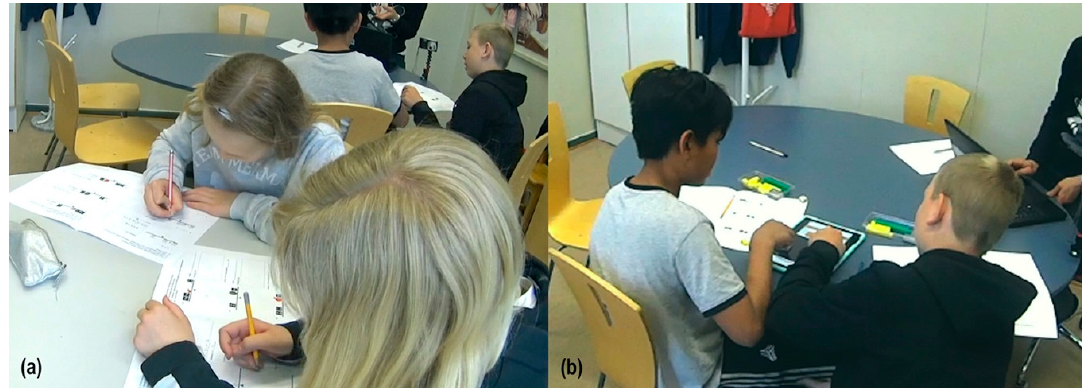
Figure 13. Fifth-graders’ communication during the intervention. ( a ) Paper-and-pencil students solving an equation silently and separately; ( b ) X-is students discussing while solving an